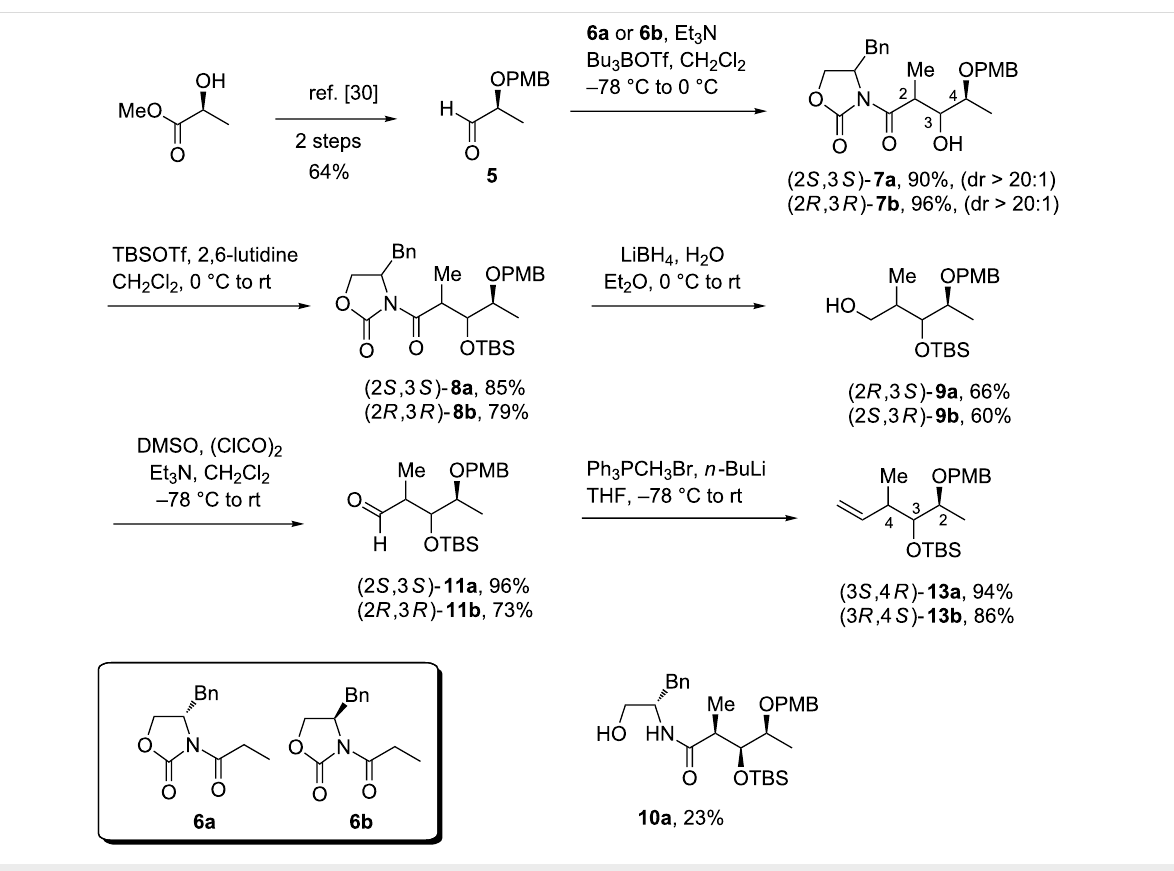
Scheme 1: Evans aldol reaction for the preparation of diastereomeric compounds 13a and 13b .